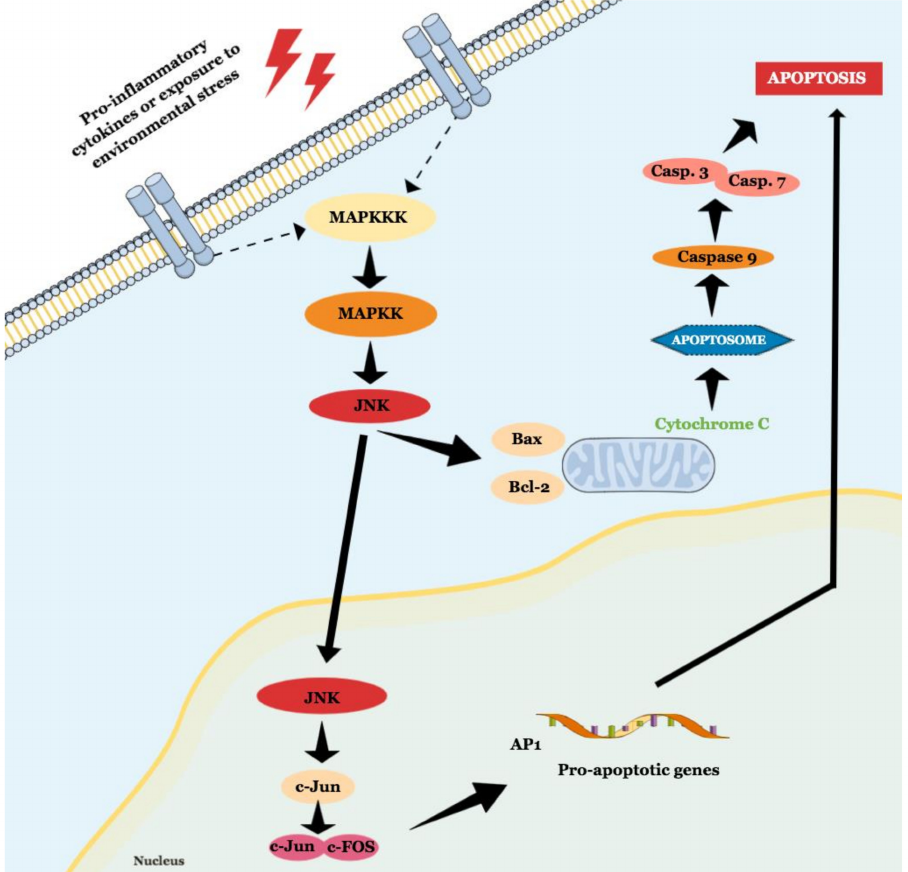
Figure 2. Schematic representation of JNK role in intrinsic and extrinsic